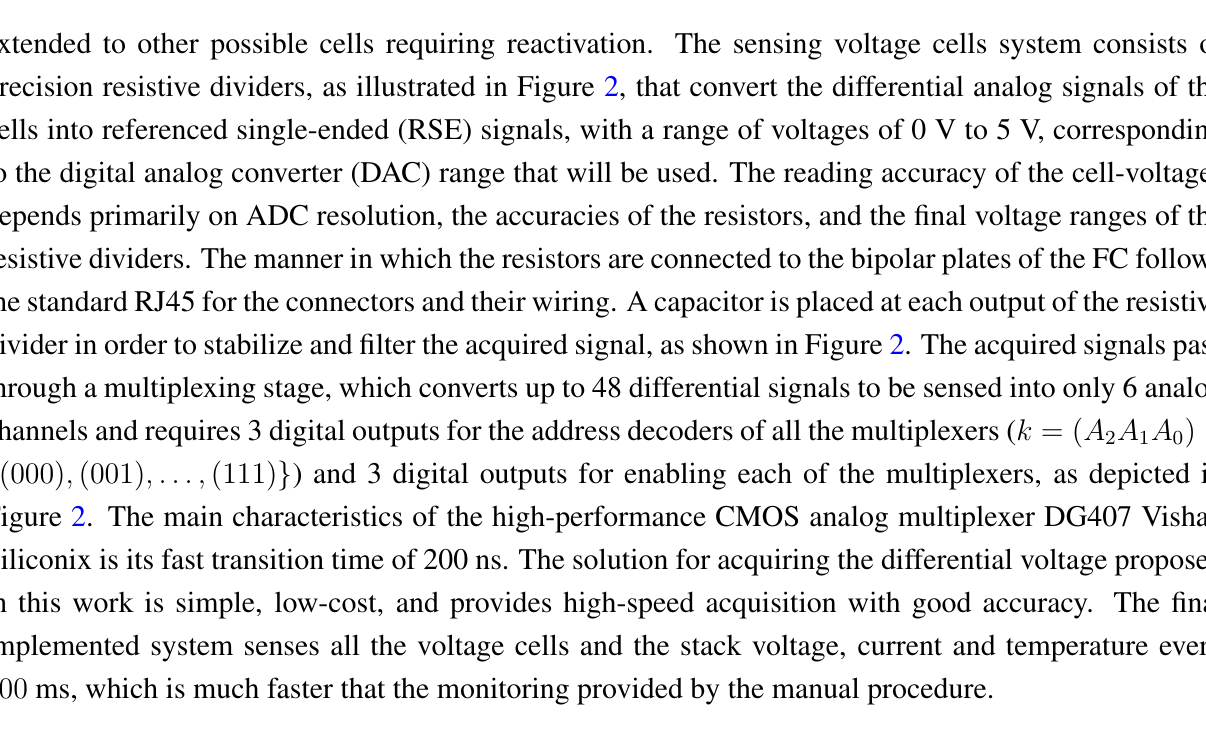
Figure 2. Circuit schematic of the multiplexing